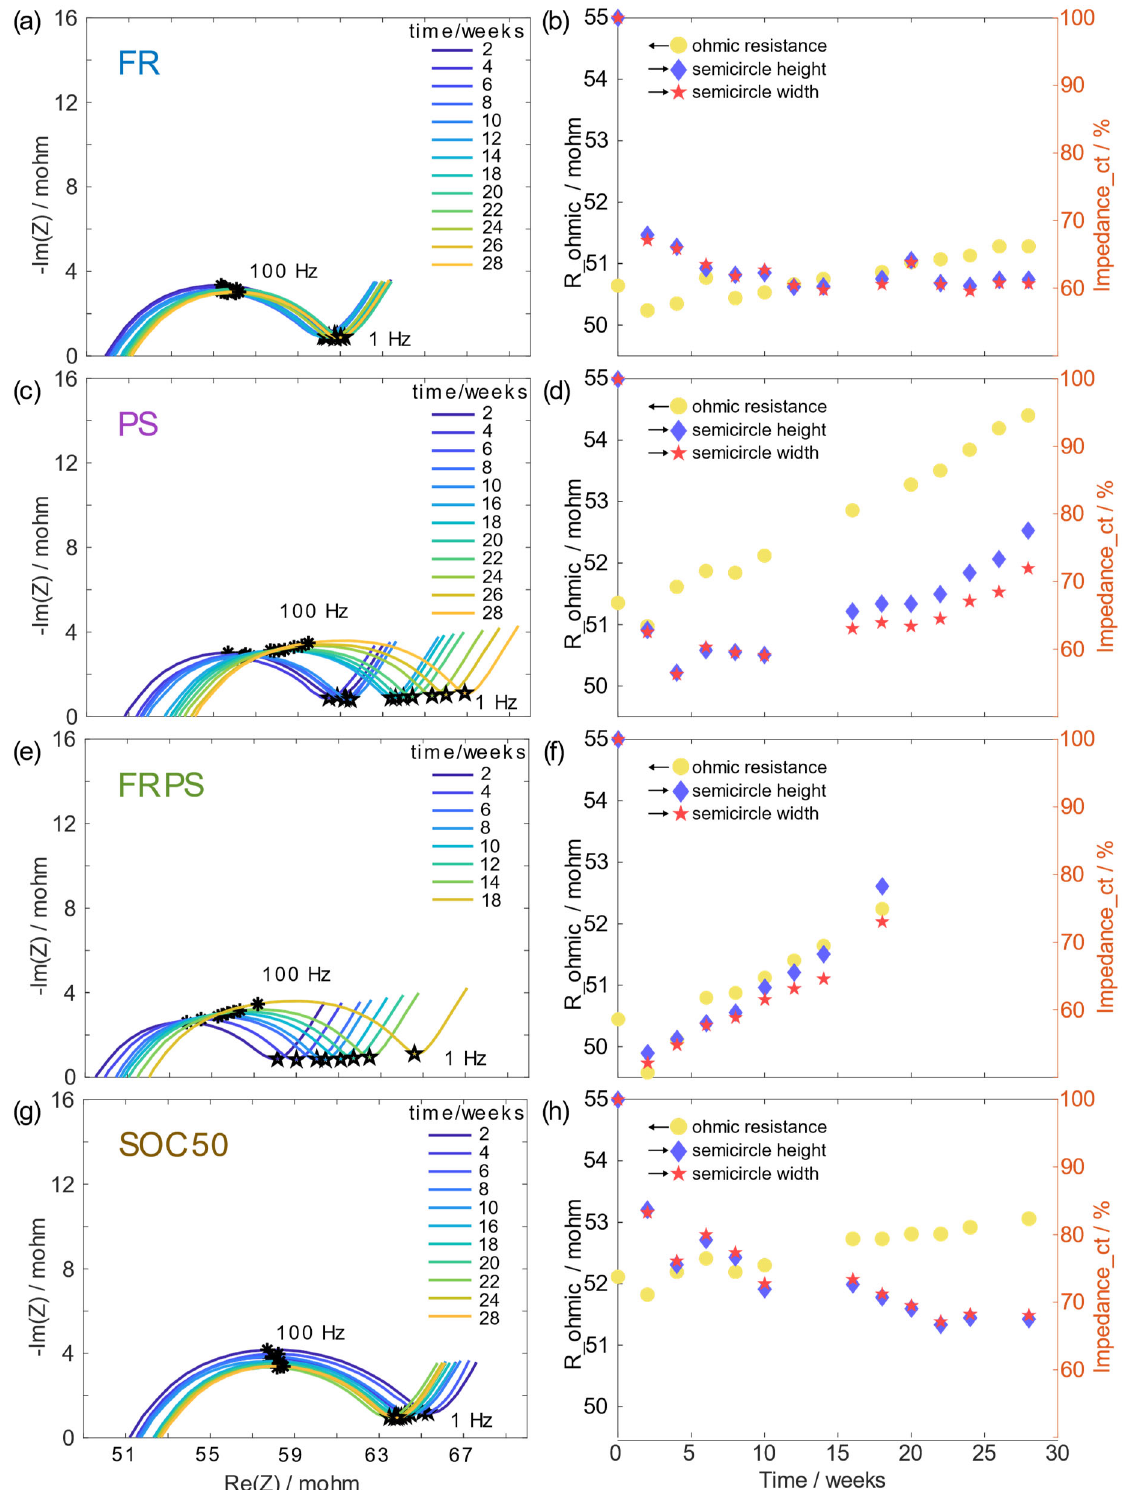
Figure 5. Impedance spectra of the cycle-aged cells and the 50% SOC calendar-aged cells. The evolution of the ohmic resistance and charge transfer impedance is highlighted to the right of the Nyquist plots. This data is the average value of duplicate cells. FR ((a), (b)), PS ((c), (d)), FRPS ((e), (f)), SOC50 ((g), (h)).